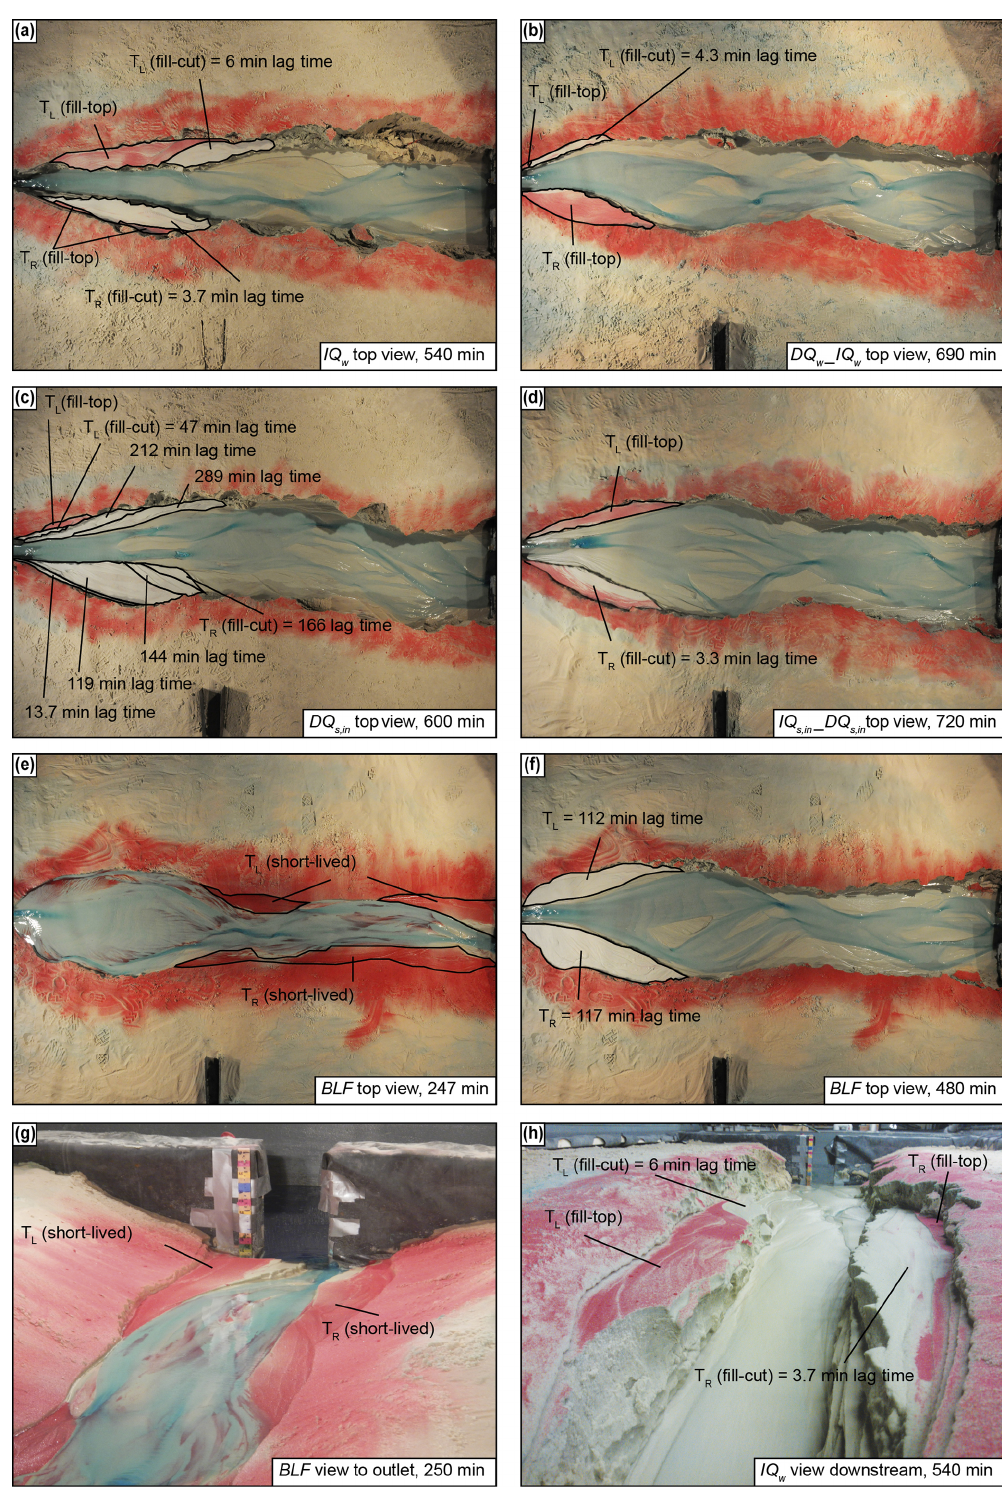
Figure 3. Fill terraces formed during experimental runs. (a–d) Top view of terraces that formed due to upstream perturbations. Remnants of red sand on the terrace surfaces indicate areas that have not been flooded after the change in boundary condition was performed (i.e., fill-top terrace). The other terrace surfaces were cut with the indicated lag times (fill-cut terraces). (e–f) During the base-level fall (BLF) experiment, terraces at the downstream end were abandoned instantly after the onset of base-level fall (250min = 10min after onset of BLF). Those terraces were destroyed shortly after they were cut. A new set of terraces formed in the upstream part ca. 112 and 117min after the onset of BLF. (g–h) Downstream view for the BLF (g) and IQ w (h) experiments.